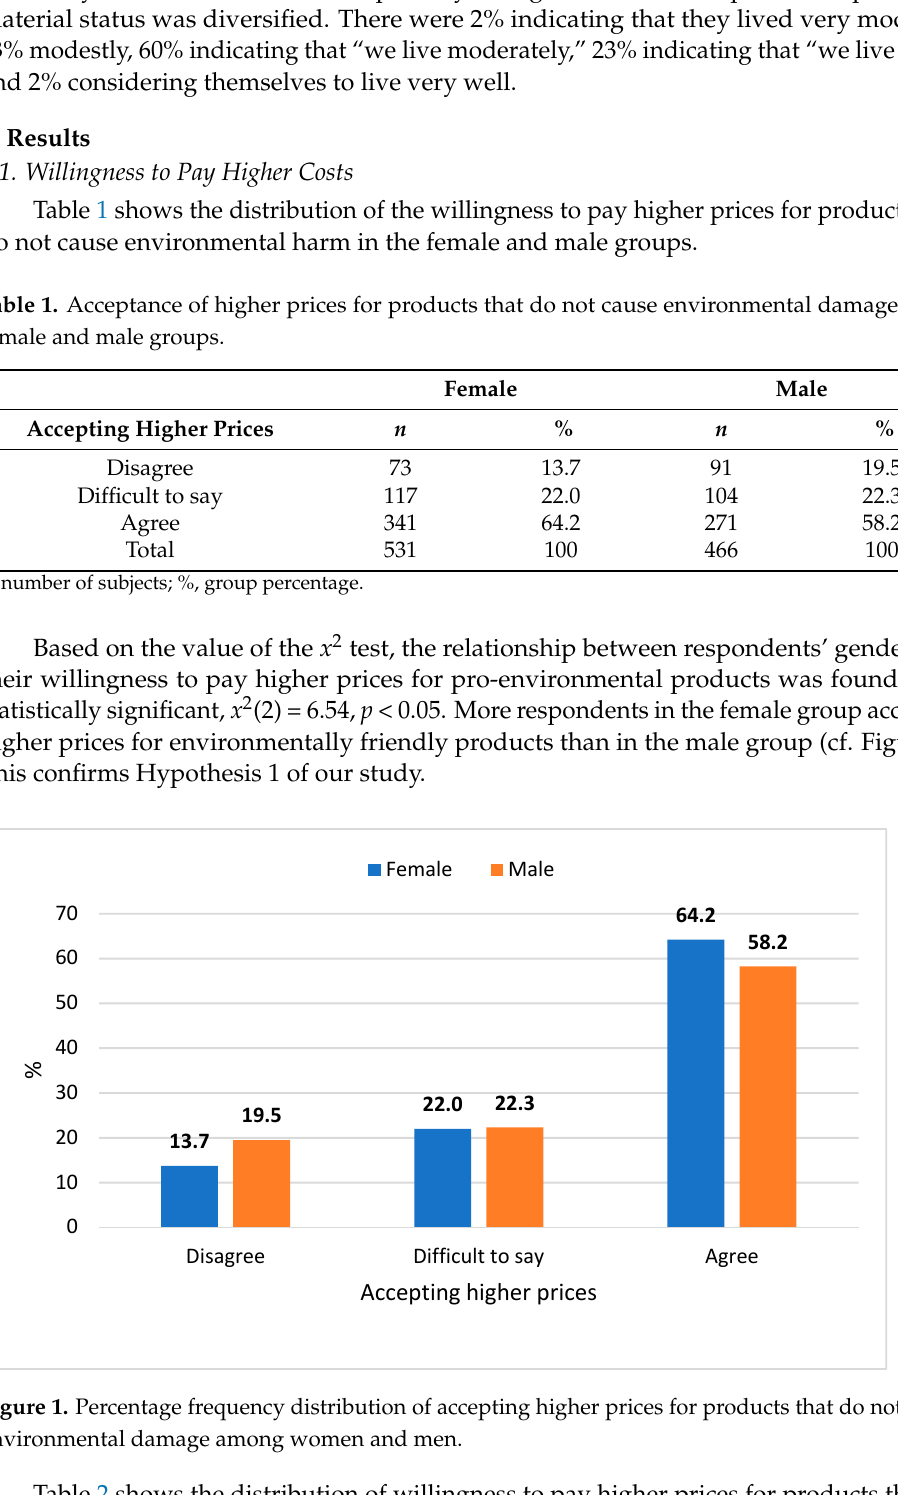
Table 2. Acceptance of higher prices for products that do not cause damage to the environment depending on respondents’ level of education.